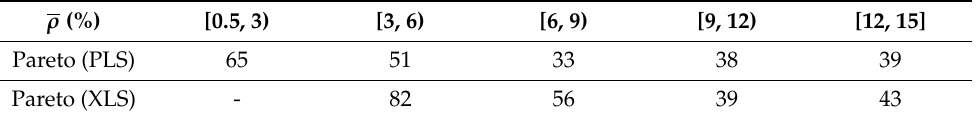
Table 4. The distribution for Pareto solutions of ρ for